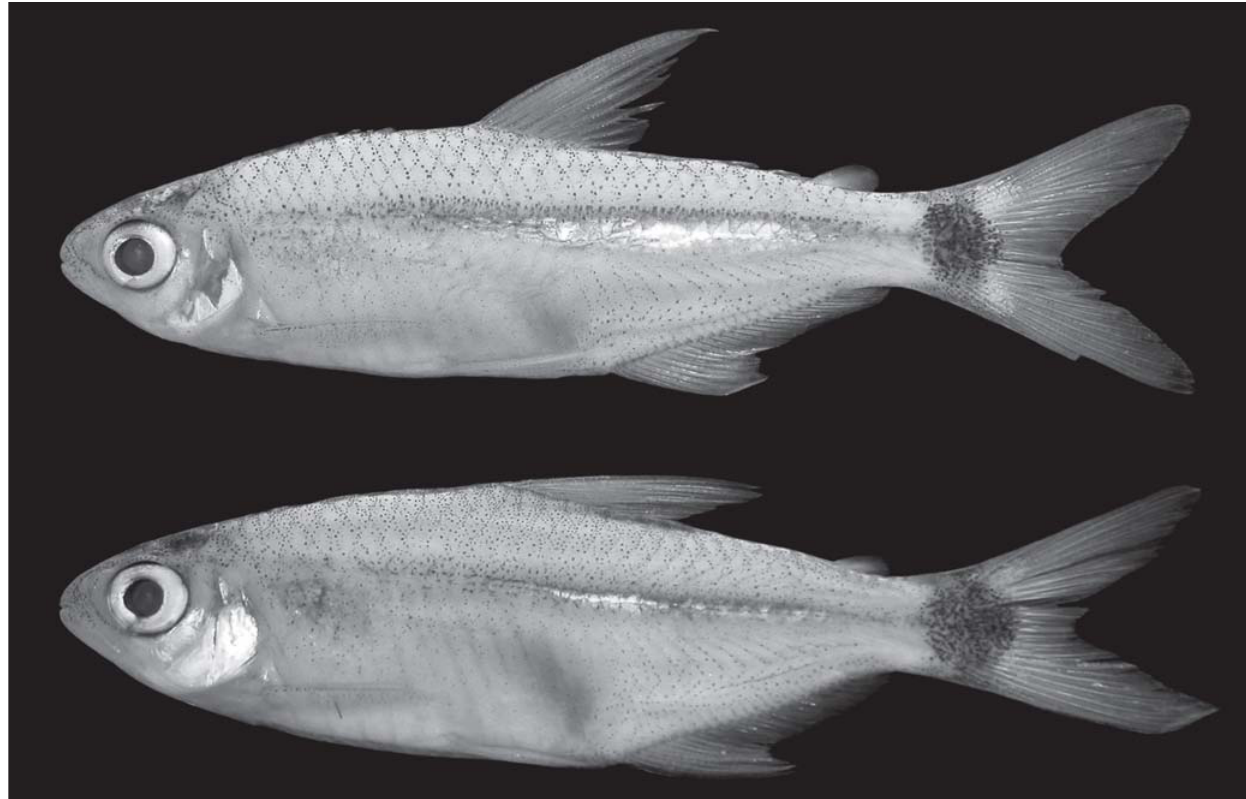
Fig. 1. Neotype of Odontostilbe fugitiva , MUSM 27501, male 34.6 mm SL (top), and specimen NRM15719, female 35.2 mm SL